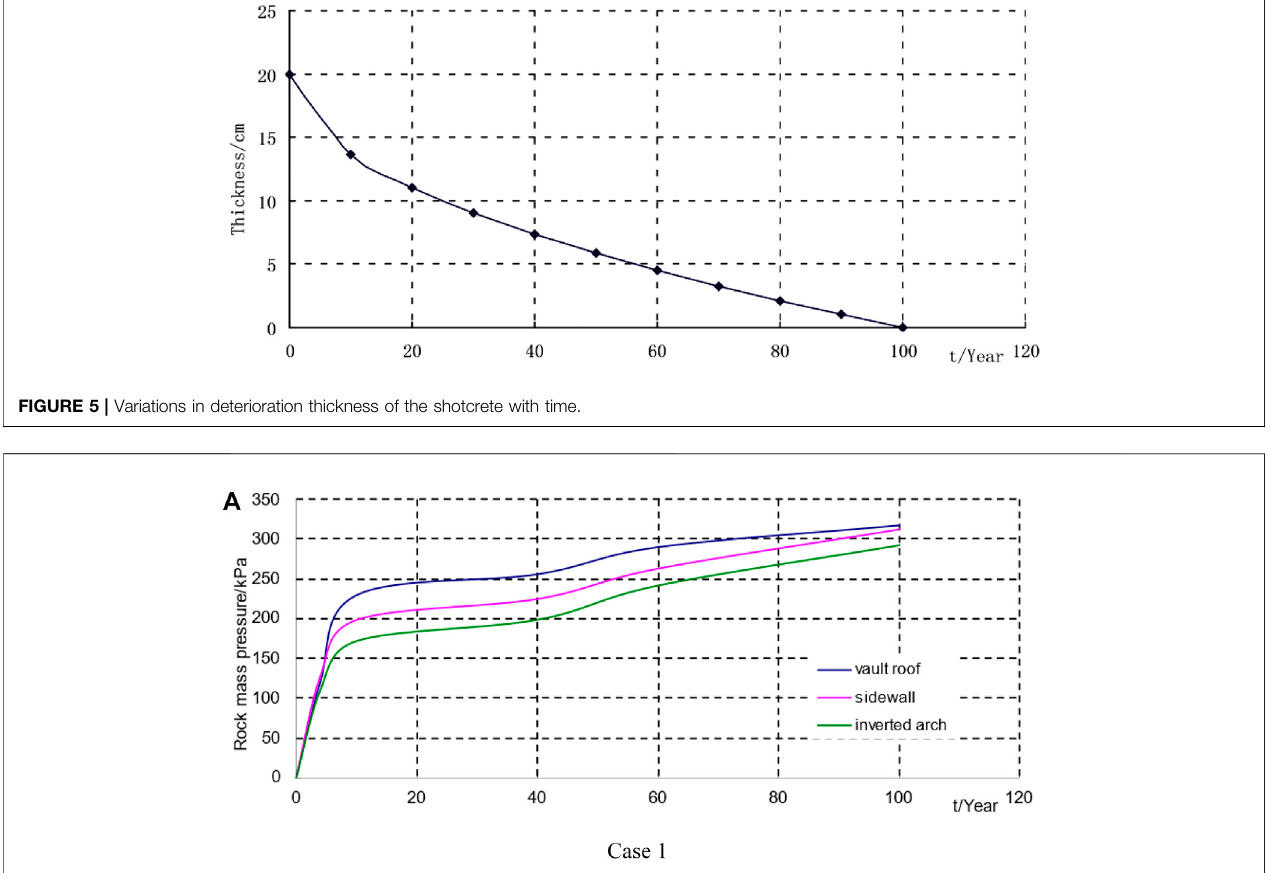
Frontiers in Earth Science |